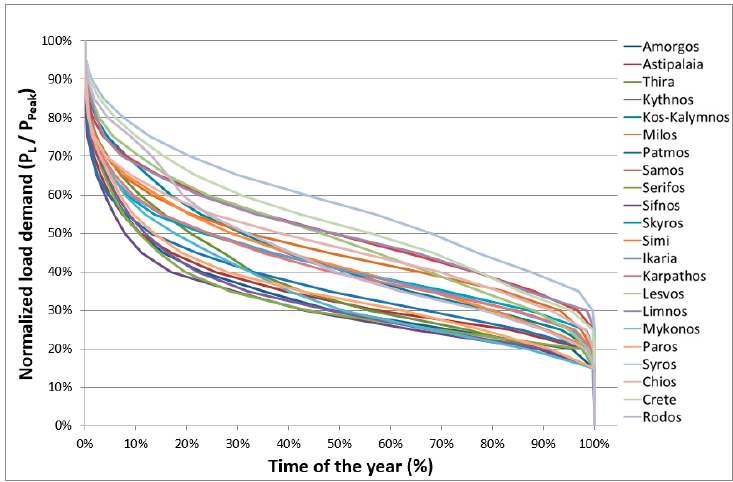
Figure 12. Annual duration curves of load demand in all the examined case studies.